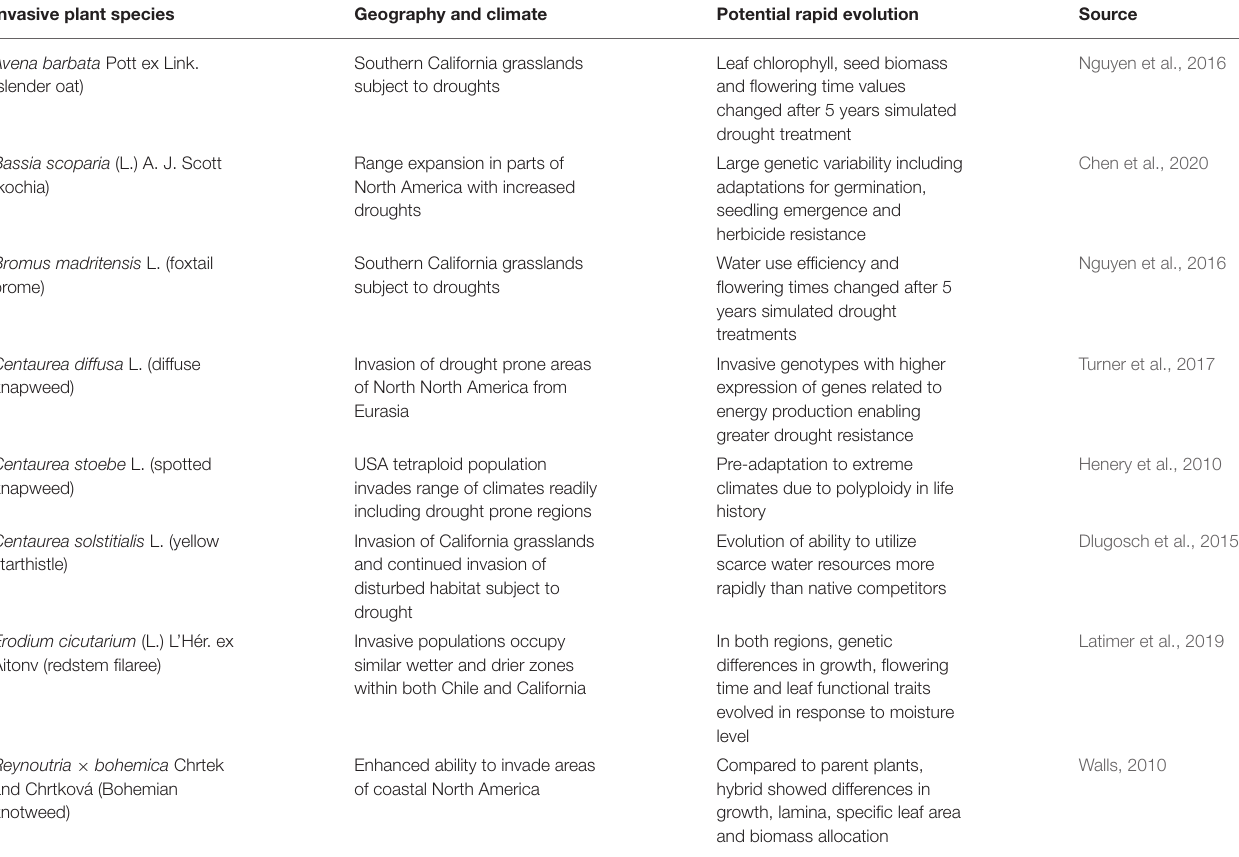
TABLE 3 | Cases demonstrating potential rapid evolution of invasive plants under climate change for species adapting to new moisture regimes in the invaded